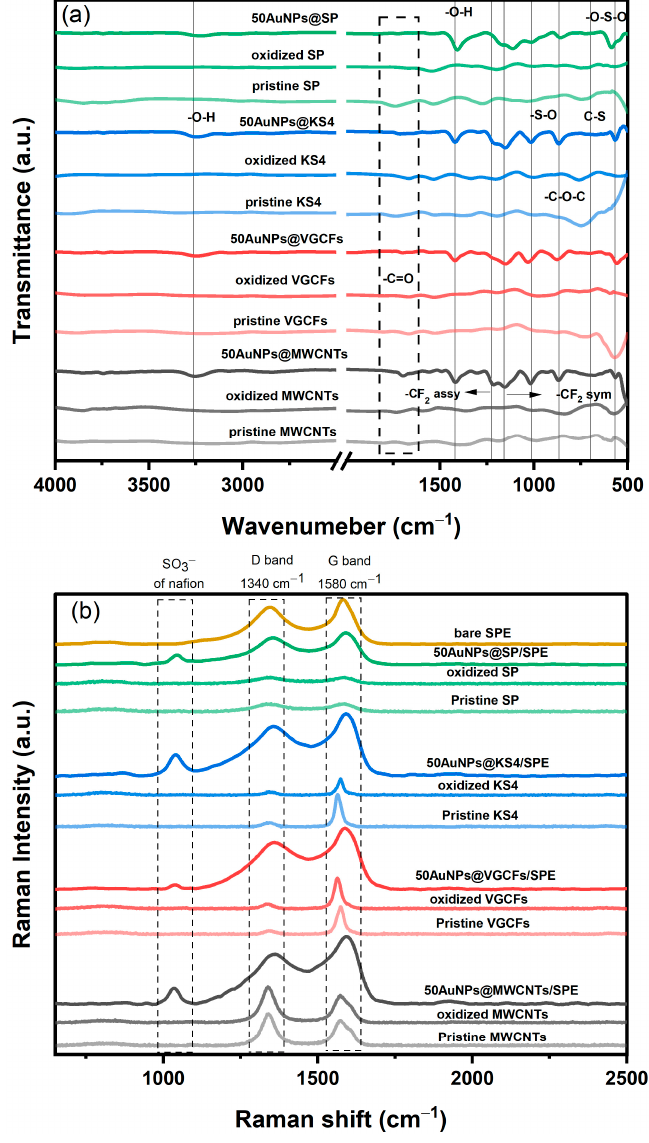
Figure 2. ( a ) FTIR of pristine, oxidized and 50AuNPs@carbon, ( b ) Raman spectra of bare SPE, pristine, oxidized and 50AuNPs@carbon composite.